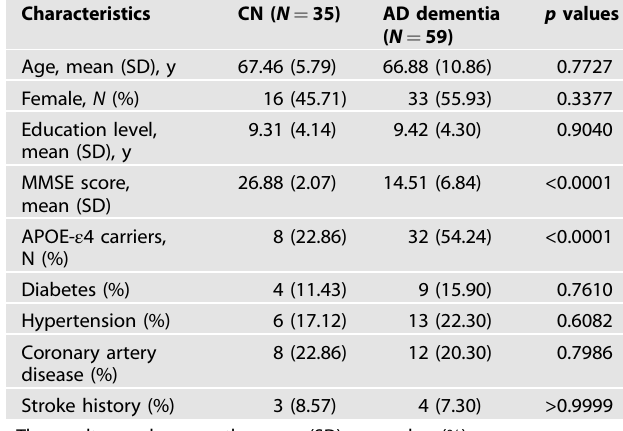
Table 1. Characteristics of all